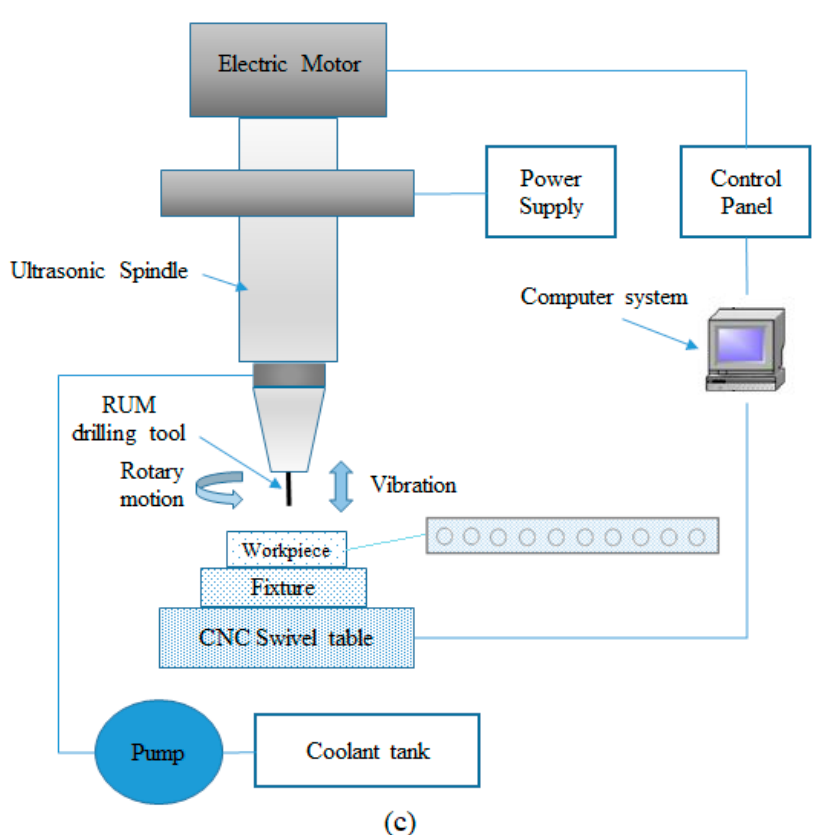
Figure 2. ( a ) DMG ultrasonic-20 linear machine, ( b ) experimental setup details, and ( c ) experimental setup schematics.